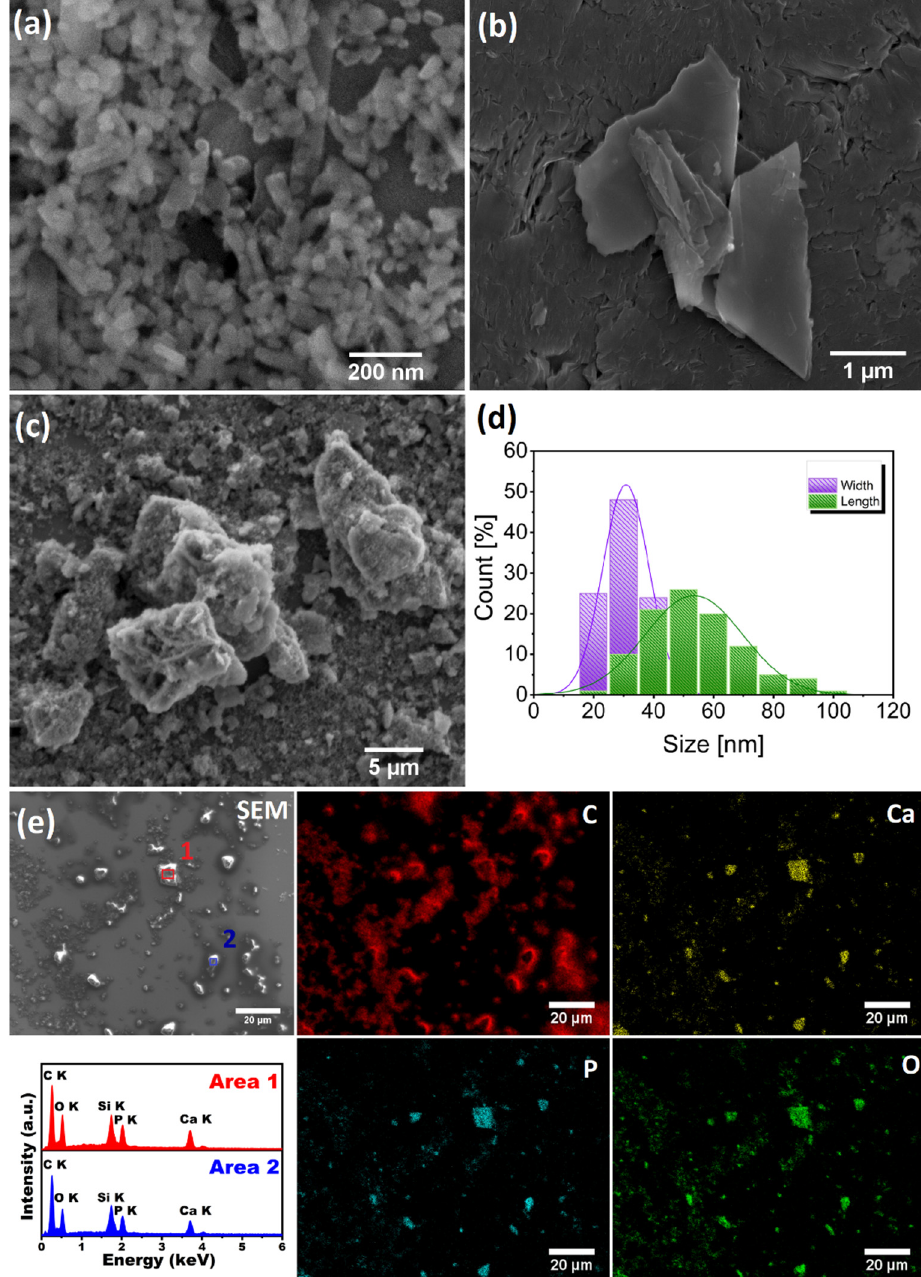
Figure 2. Representatives SEM images of the ( a ) nanohydroxyapatite (nHAp), ( b ) amorphous imatinib (IM) and ( c ) nHAp modified by imatinib (nHAp / IM), ( d ) histogram of the nHAp grain size distribution (length-wise and width-wise diameters), ( e ) EDS elemental mapping of the nHAp modified by imatinib together with EDS spectra for selected areas.